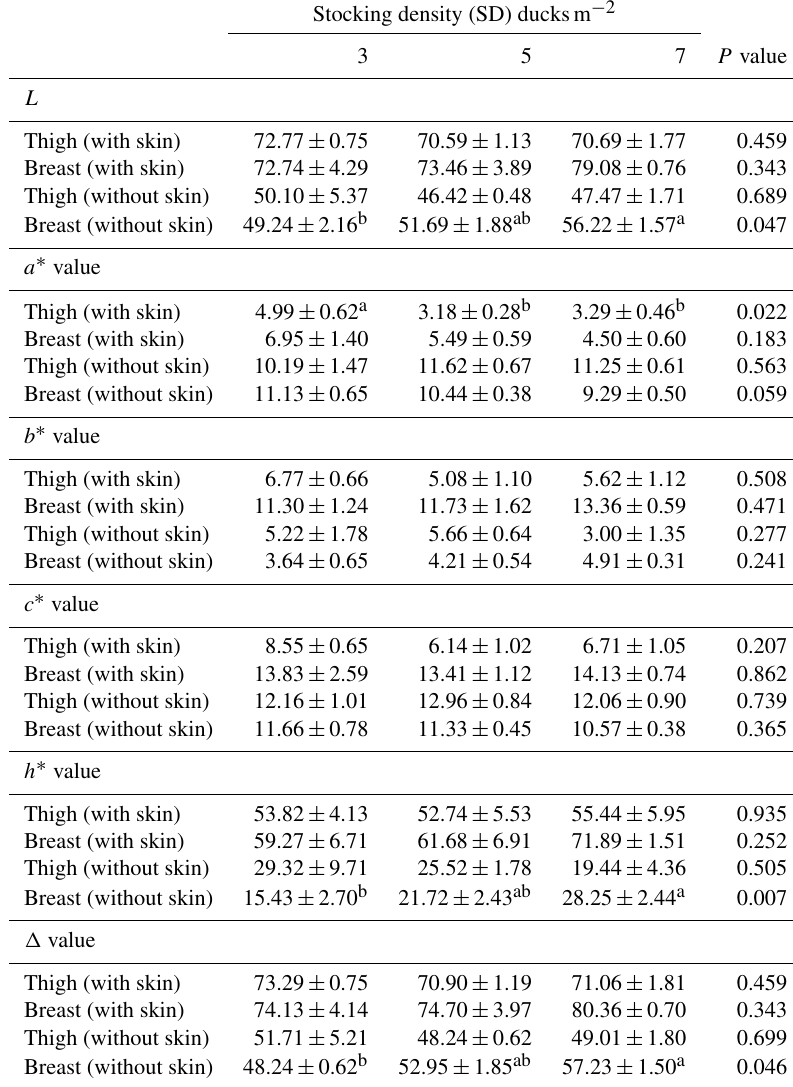
Table 4. The effects of stocking density on the meat colour of Pekin ducks (mean ±